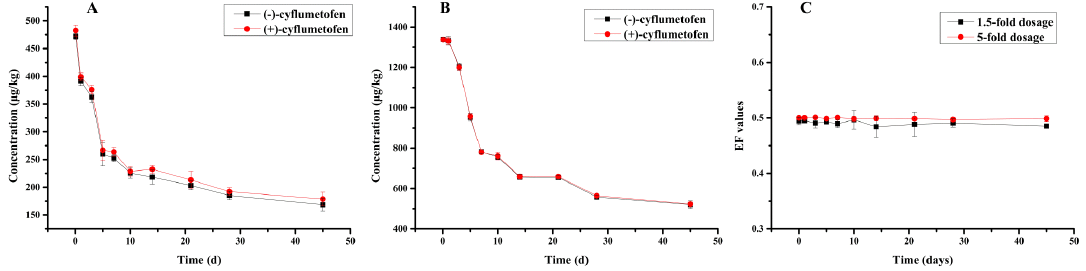
Figure 3. Degradation of cyflumetofen under field conditions, ( A ) 1.5-fold applied dosage; ( B ) 5-fold applied dosage; ( C ) EF value.